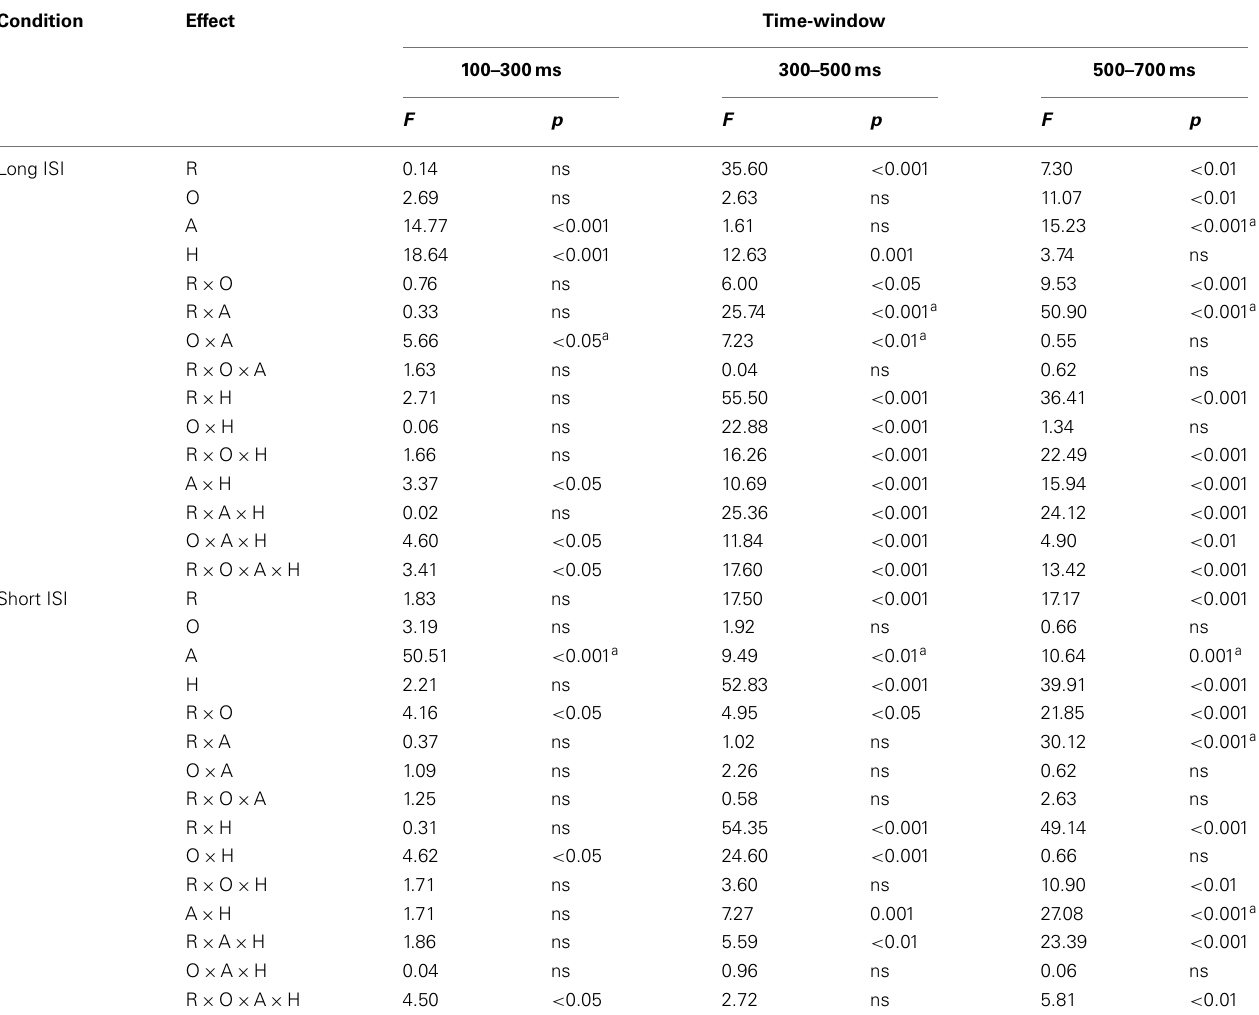
Table 4 | Statistics for all effects of theANOVAs conducted on mean amplitudes in the three time-windows analyzed.